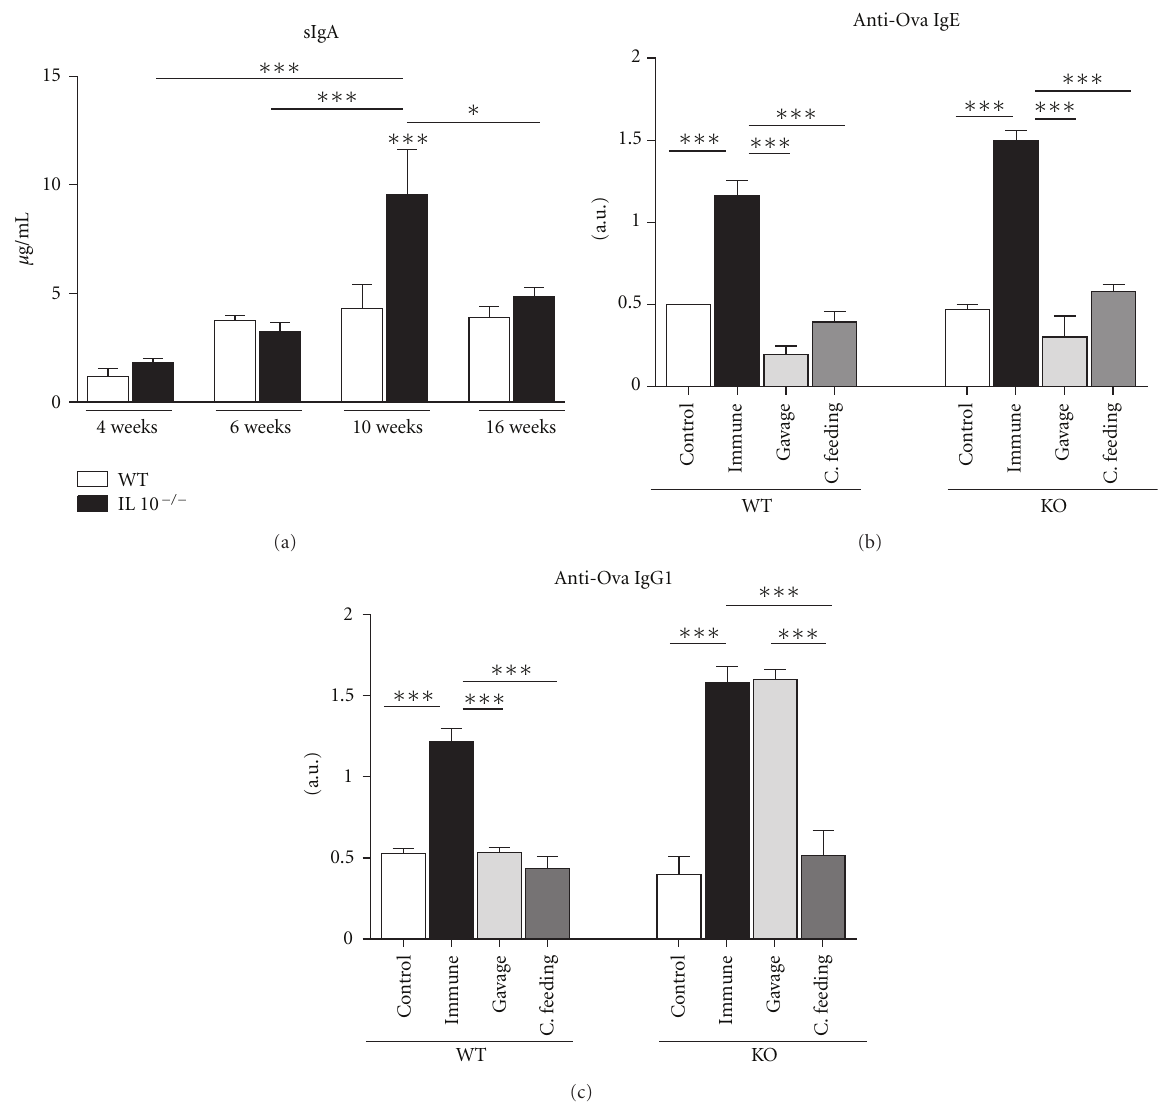
Figure 6: Secretory IgA and oral tolerance. Intestinal feces from 4-, 6-, 10-, or 16-week-old IL-10 − / − mice were collected and total sIgA (a) was measured by ELISA. 16-week-old IL-10 − / − or wild-type mice received Ova either by gavage or by continuous feeding. Seven days later mice were sensitized by an intraperitoneal (i.p.) injection of 0.2mL saline (0.9% NaCl) solution containing 10 μ g OVA (Sigma, St. Louis, MO) adsorbed in 1 mg aluminum hydroxide. Fourteen days later, animals received the same dose of OVA in PBS. Control animals received 0.2mL sterile saline. Anti-Ova IgE and IgG1 antibodies were measured by ELISA. A.U.: arbitrary units. Bars represent the mean ± SEM of 5 mice per group. Asterisks represent di ff erence between groups ( ∗ P < 0 . 05 or ∗∗∗ P < 0 .